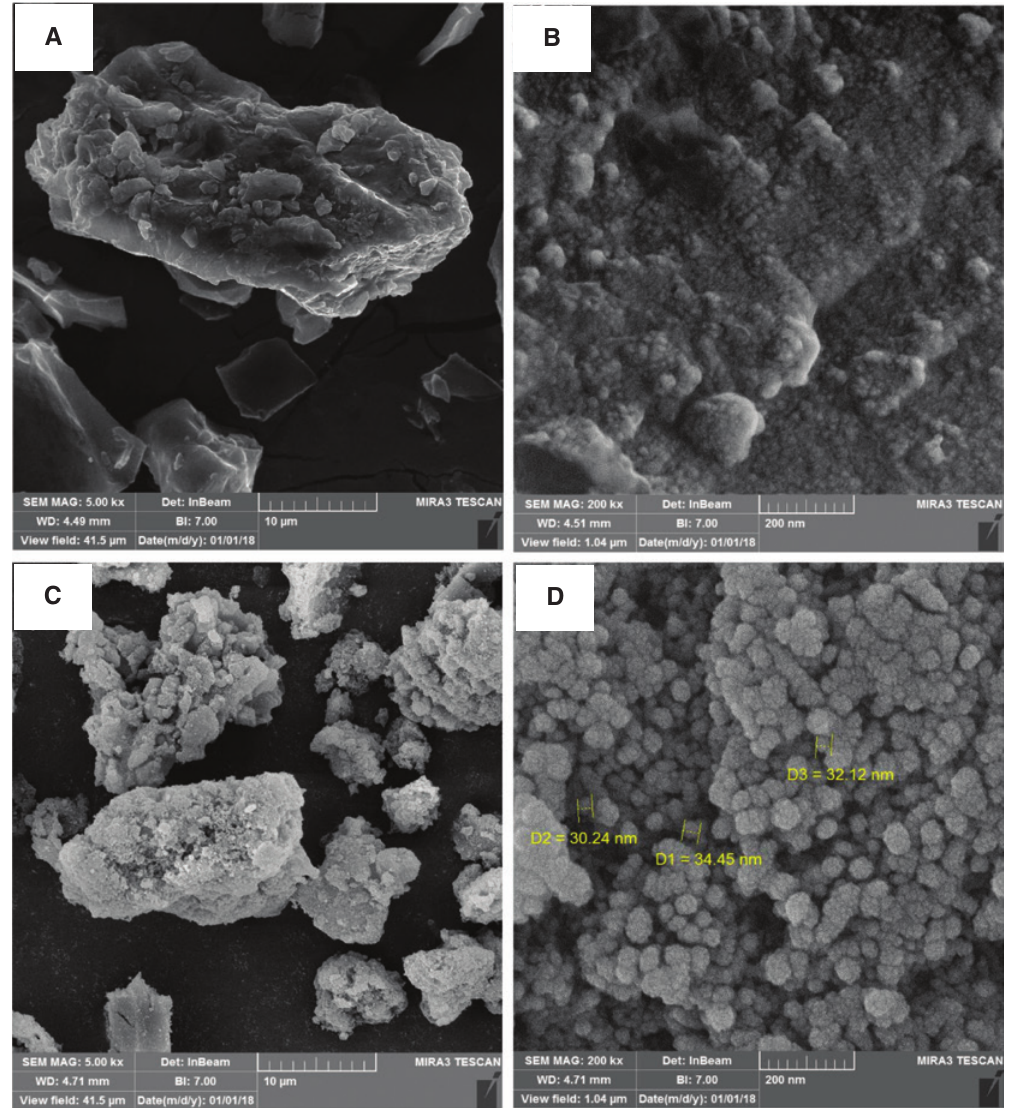
Figure 3: FE-SEM images of pristine biochar (A and B) and engineered biochar (C and D) at various magnifications. FE-SEM images of PRB (A, scale 10 μ m; B, scale 200 nm) and PRB-nZVI (C, scale 10 μ m; D, scale 200